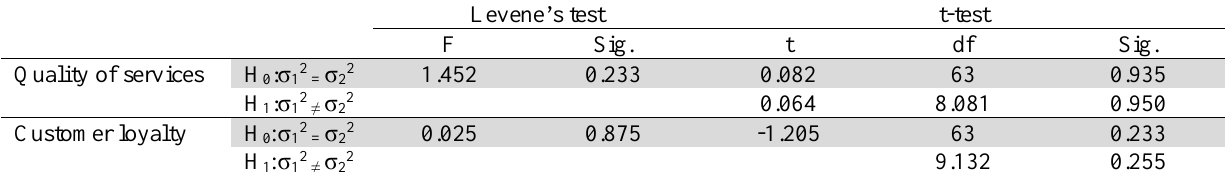
The summary of Levene’s test and t-test on the effects of gender on quality of services and